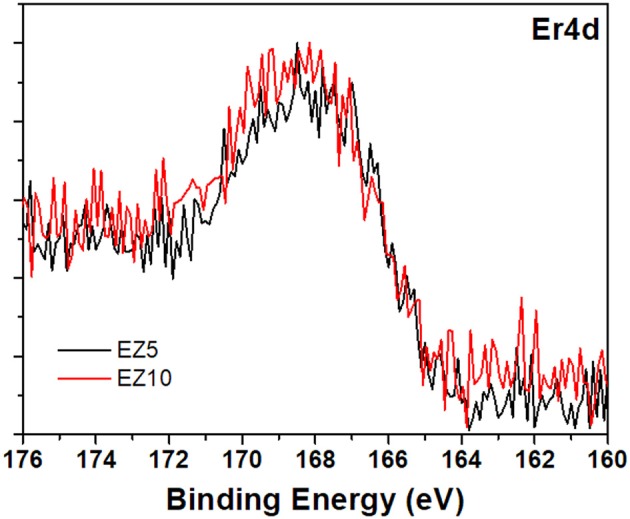
XPS high resolution spectrum on Er4d for 5 and 10% Er-doped zirconia.